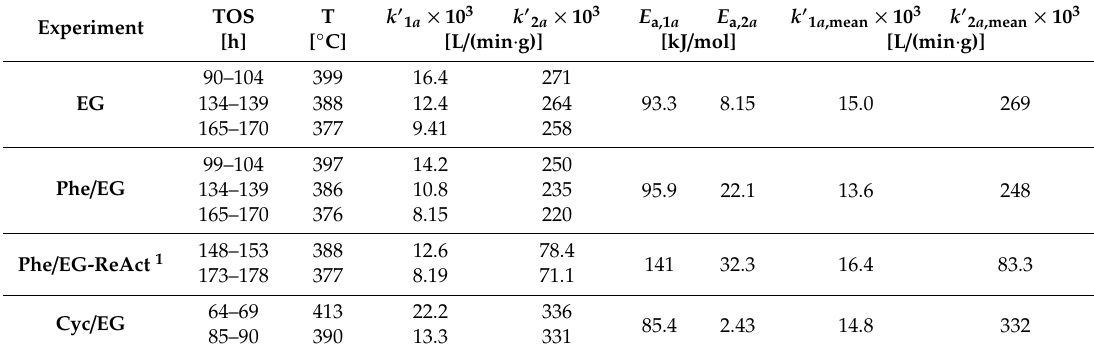
Table 1. First order rate constants as a function of reaction temperature, and apparent activation energies and rate constants at the mean temperature of 395 ◦ C for the conversion of ethylene glycol (reactions 1 a and 2 a ) as pure compound and in mixture with phenol and cyclohexanol.